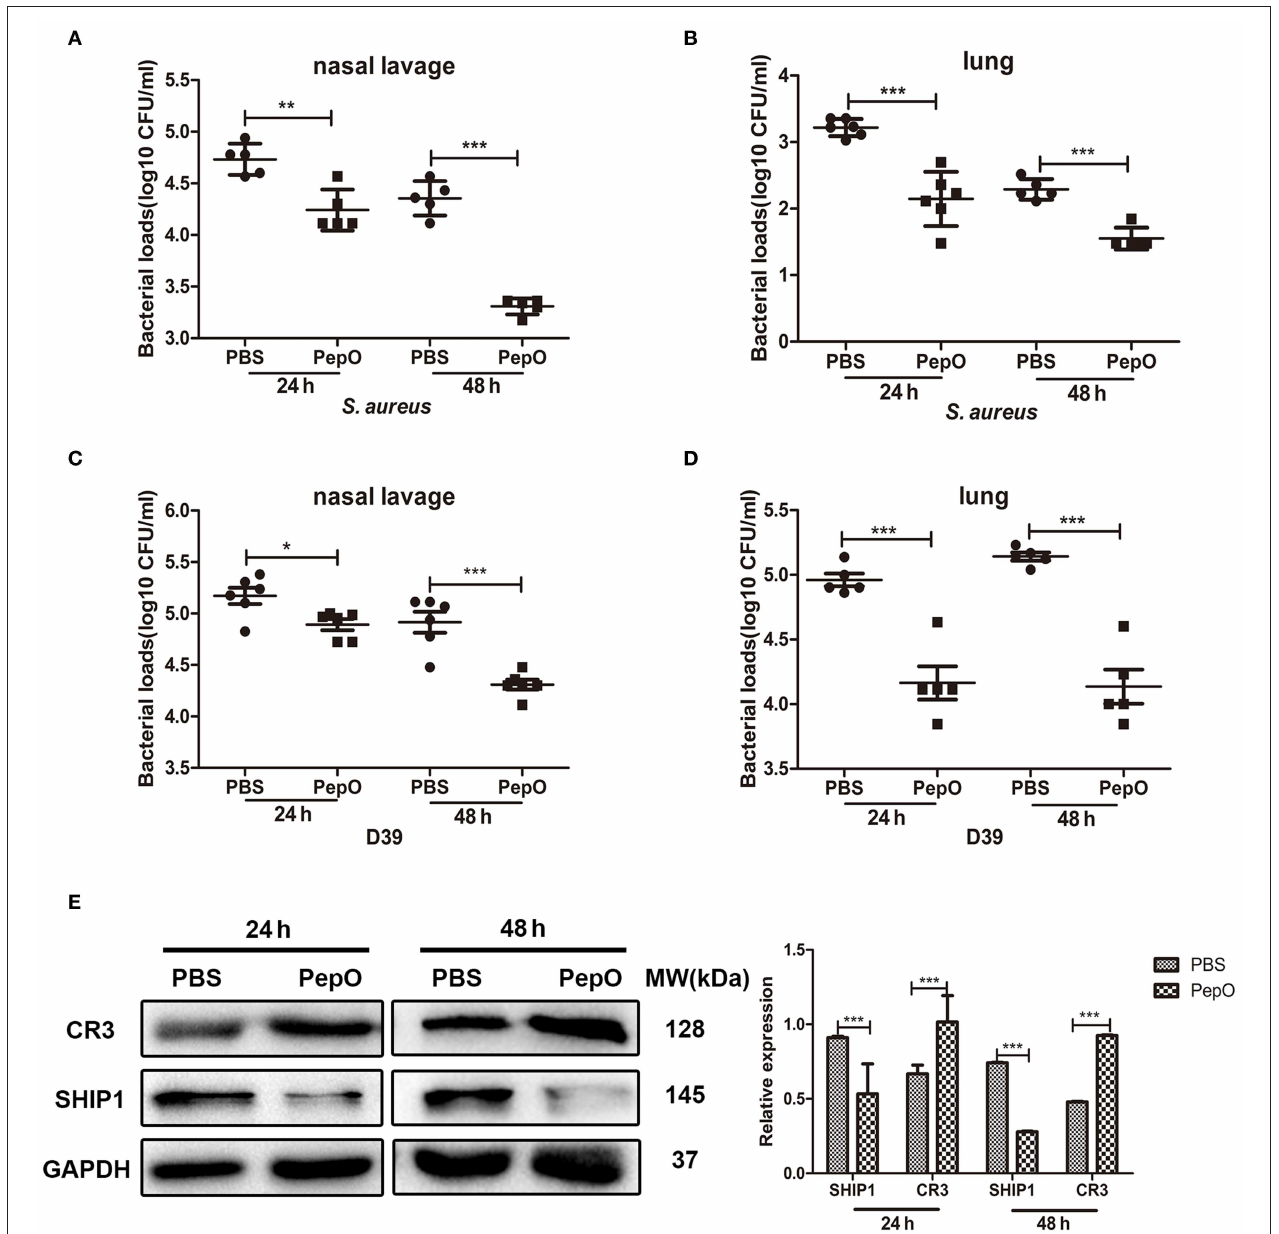
FIGURE 4 | PepO promotes the clearance of S. aureus and S. pneumoniae in C57BL/6 mice. (A–D) C57BL/6 mice were intranasally administrated with PepO or an equivalent volume of PBS for 24h followed by an intranasal infection of S. aureus (A,B) or D39 (C,D) for 24 or 48h. The number of viable S. aureus or D39 in nasal lavage liquids and lungs was determined. Data are shown as averaged ( ± SD) bacterial loads of at least five mice per group from one representative experiment of two. (E) Immunoblot showed the expression of SHIP1 and CR3 in cells from bronchoalveolar lavage fluids after 24 and 48h PepO treatment. Representative bands from three independent repeated experiments are shown. Statistical analysis was performed by student’s t -test. *** p < 0.001, ** p < 0.01, * p < 0.05. difference in bacterial loads of D39 in lung tissues between shown in Figure 5A . As shown in Figures 5B,D , the bacterial the two groups with PepO treatment, the bacterial loads in loads in nasal lavage fluids were significantly increased in the SHIP1 over-expression group showed an increased tendency SHIP1 over-expression group at each time point with PepO compared with the control group ( Figures 5C,E ). These results treatment, as compared with the control group. The bacterial indicate that the down regulation of SHIP1 plays a role loads of S. aureus in lung tissues at 48 h were also significantly in the enhanced clearance of S. aureus and D39 in PepO- higher in the SHIP1 over-expression group than in the control treated group with PepO treatment. Although there was no significant